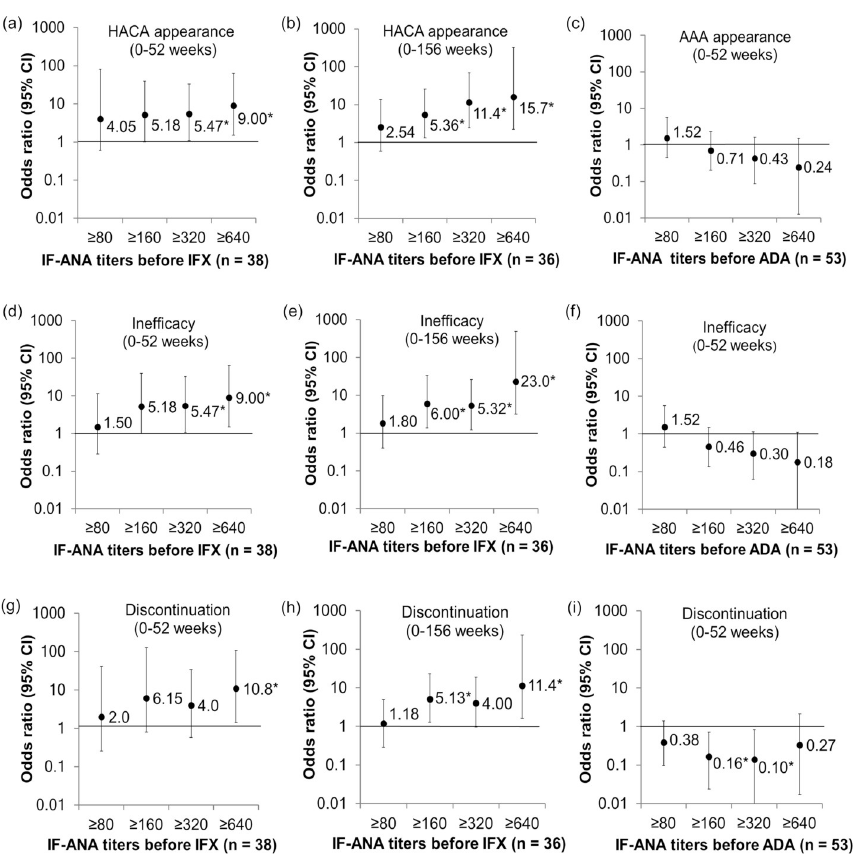
Fig 5. IF-ANA titers before IFX therapy were associated with HACA appearance and the treatment effect. Odds ratios for each outcome were calculated using simple logistic regression models. Simple model of HACA appearance between 0–52 weeks (a) or between 0–156 weeks (b) in the patients positive for IF-ANA titers of � 80, � 160, � 320, � 640 before starting IFX therapy. Simple model of AAA appearance between 0–52 weeks in the patients positive for IF-ANA titers of � 80, � 160, � 320, � 640 before starting ADA therapy (c). The same analyses as for (a)–(c) were performed for treatment inefficacy in (d)–(f), and for treatment discontinuation in (g)–(i). In (b), (e), and (h), two patients treated with IFX were excluded from the analysis due to discontinuation by hospital transfer or financial reasons. Mean values are indicated by dots with numbers, and 95% confidence intervals are indicated by two-sided lines. HACA, anti-IFX antibodies; AAA, anti-ADA antibodies. � , P <